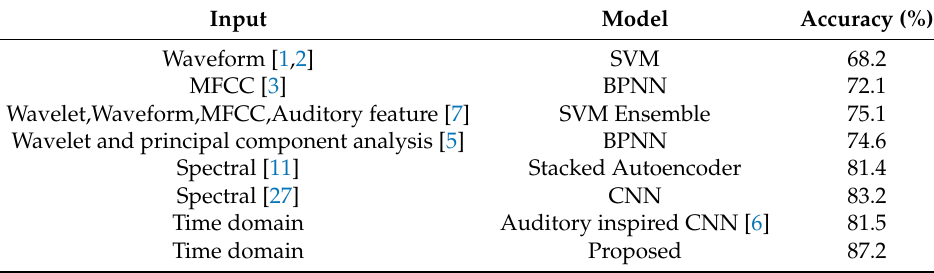
Table 1. Comparison of the proposed model and other